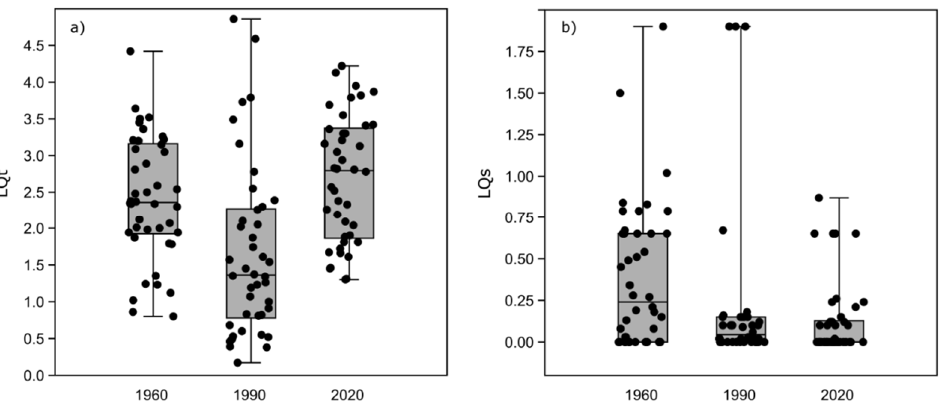
Figure 6. Summary box-and-whisker plots with jitters presenting changes in litter quality of trees (LQt) ( a ) and shrubs (LQs) ( b ) between three studied surveys of the riparian forest in the Odra River Valley (SW Poland). The central line of each box indicates the median value, box boundaries the lower (25%) and upper (75%) quartiles, and whiskers the range of values.